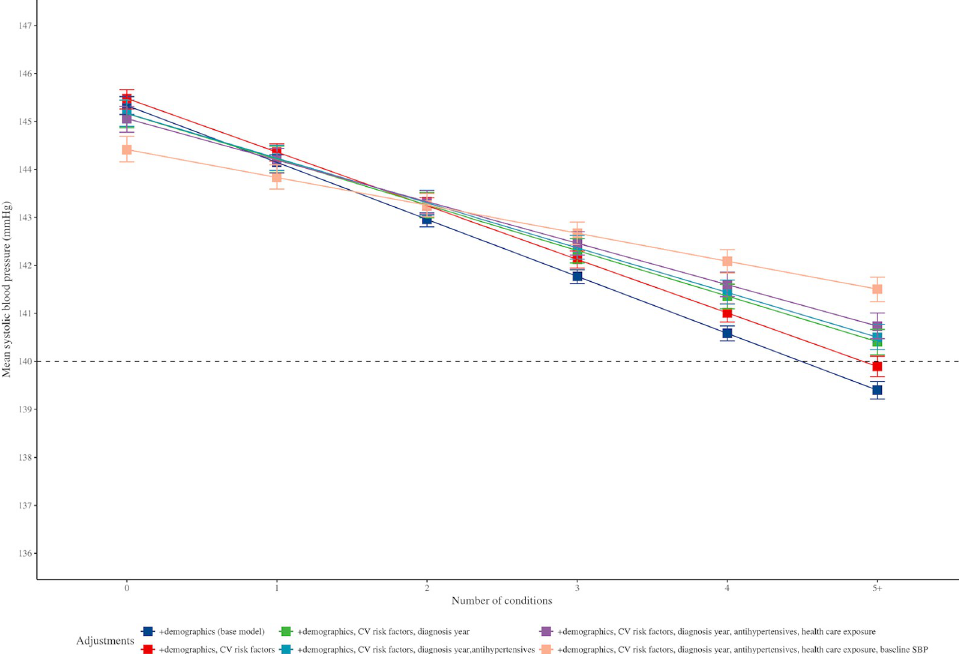
Fig 4. Association of SBP with number of conditions at 1 year after diagnosis of hypertension, after sequential adjustment of potential confounders. CV, cardiovascular; SBP, systolic blood pressure.